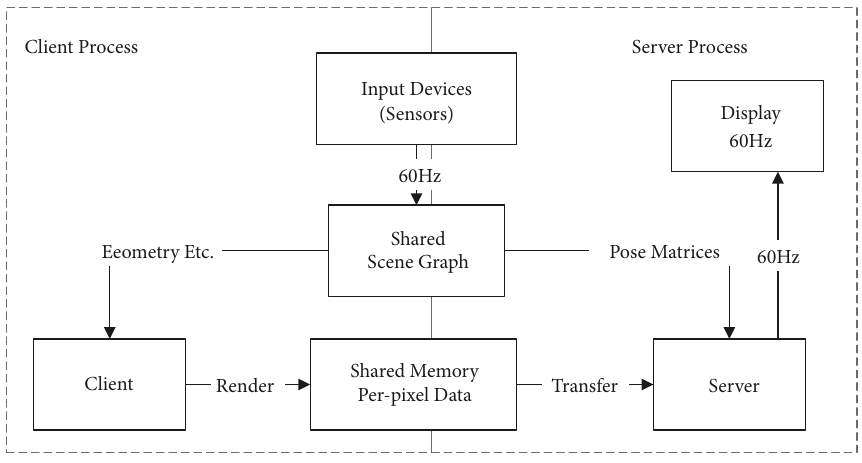
Figure 6: Overview of the gaze point rendering application architecture (adapted from